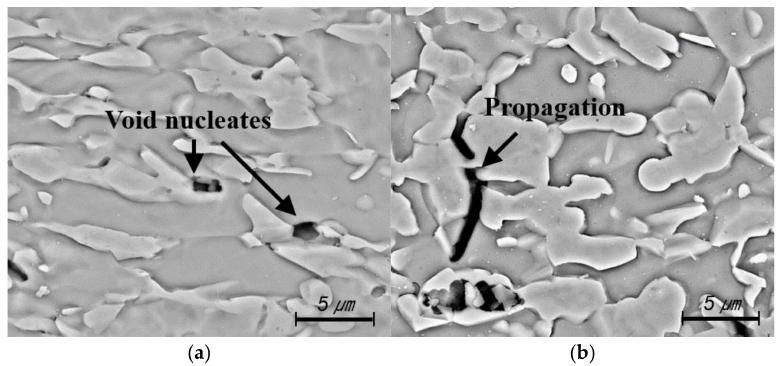
Figure 10. SEM observations of HAZ of 10% of the elongated tensile specimen: ( a ) formation of voids at interface between phases and ( b ) propagation of nucleated voids to ferrite matrix. Specimen was prepared using a laser power of 4 kW and a welding speed of 10